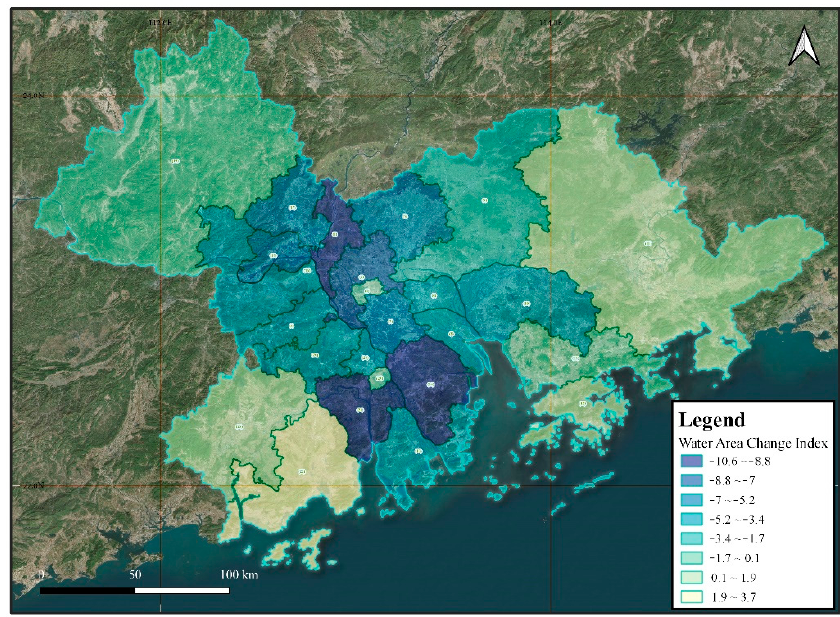
Figure 12. Distribution of each unit for waterbody area change index in GBA from 2013 to 2019.